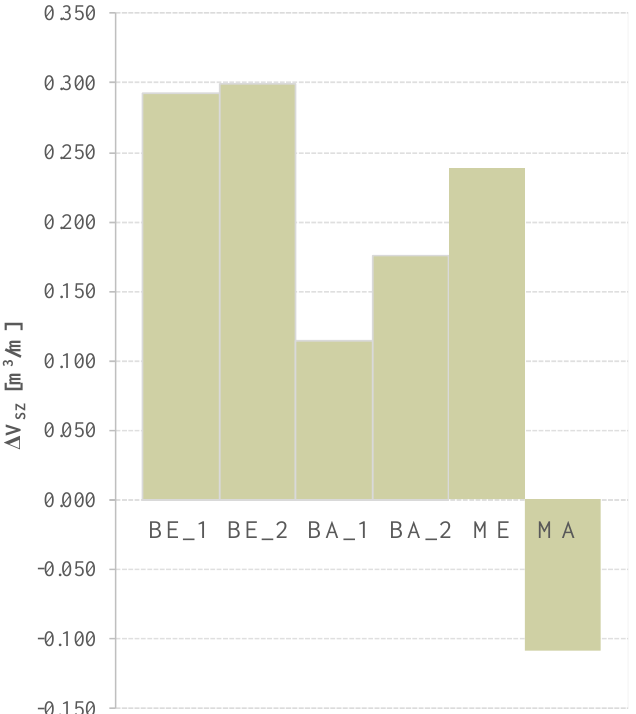
Figure 9. Net sand volume variation in the emerged swash zone (water depth > 0) after 24 min of wave generation: positive values represent accretion or landward transport; negative values represent erosion or seaward transport, for bichromatic and monochromatic tests.